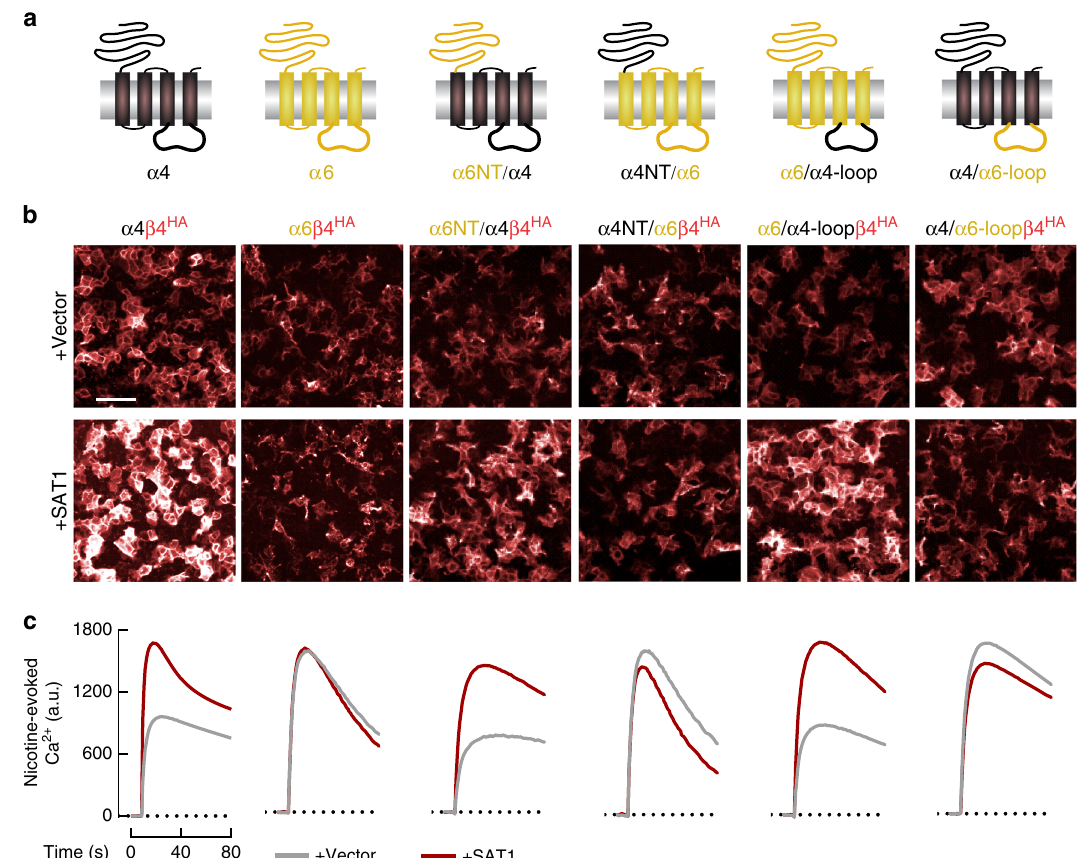
Fig. 4 The nAChR TM3-TM4 cytosolic loop determines regulation by SAT1. a Schematics of chimeric α 4- α 6 constructs. b Fluorescent anti-HA labeling of non-permeabilized HEK293T cells co-transfected with cDNAs encoding α 6, α 4, α 4- α 6 chimeric constructs and extracellular HA-tagged β 4 with or without SAT1 as indicated. All cDNA combinations contained BARP and SULT2B1. Scale bar = 50 μ m c . Agonist-evoked Ca 2 + traces from HEK293T transfected as indicated. The α 4 cytosolic loop domain is necessary and suf fi cient for SAT1-mediated regulation for all chimeras. Note that data in b and c are quanti fi ed in Supplementary Figs. 4b,